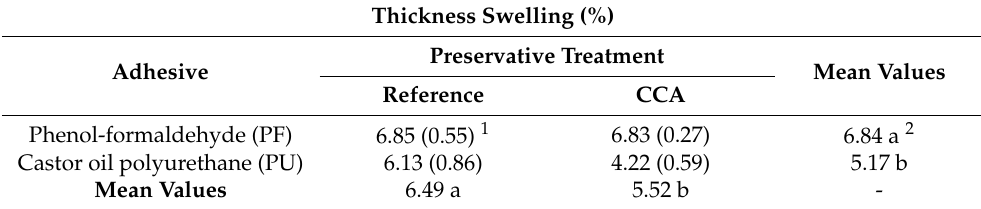
Table 5. Results: thickness swelling.